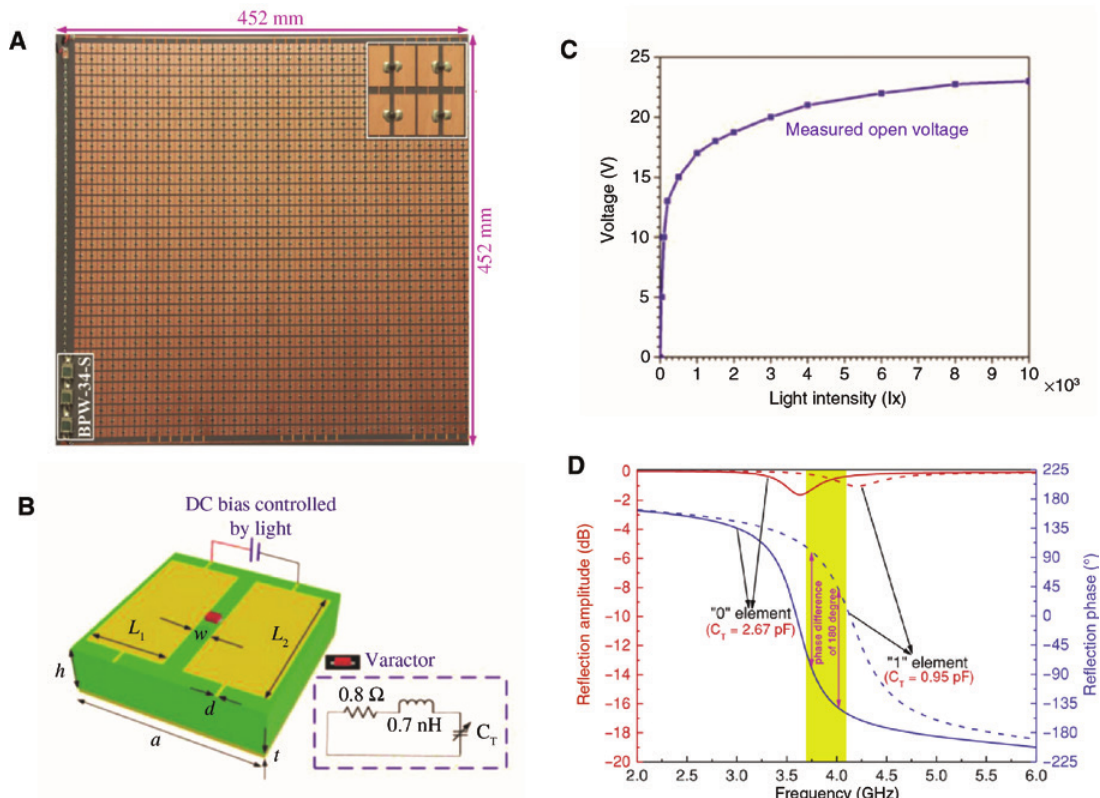
Figure 3: The illustration of the proposed light-controlled information metasurface in [48]. By remotely changing the intensity of the illumination light, the voltage generated by the photodiodes can be dynamically controlled. (A) The fabricated sample of the information metasurface. (B) The unit cell of the light-controllable information metasurface. The DC bias of the varactor is provided by the photodiodes which are controlled by LED array. The inset shows equivalent lumped elements model of the varactor. (C) The measured relationship between the bias voltage generated by photodiode array and the intensity EV of illumination light. (D) Simulated reflection amplitudes and phases of the designed “0” and “1” element from 2.0 to 6.0 GHz, respectively. The yellow area presents the phase differences of the designed “0” and “1” element, ranging from 160 ° to 196 ° , when the frequency changes from 3.69 to 4.10 GHz. The two violet double arrow lines indicate the phase difference of the designed “0” element and “1” element. Obviously, the phase difference is ≈ 180 ° at 3.75 and 4.02 GHz. Adapted from